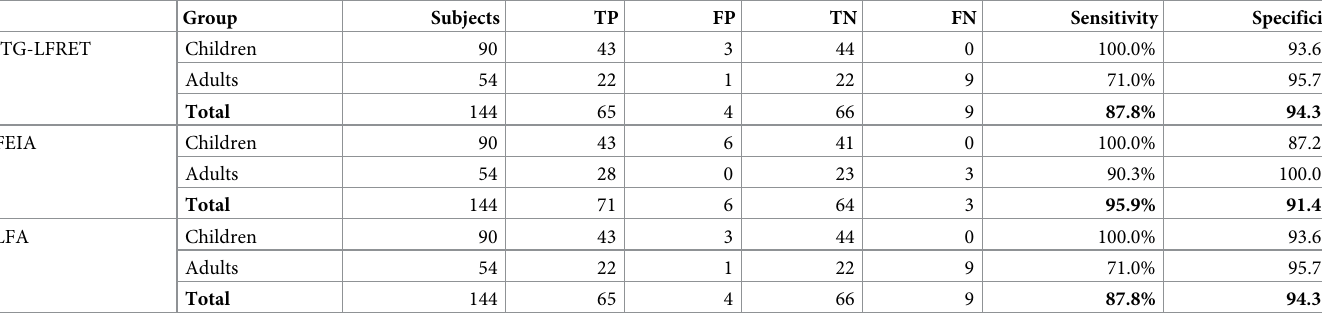
Table 1. Sensitivity and specificity of LFRET, FEIA and LFA by age group and altogether.